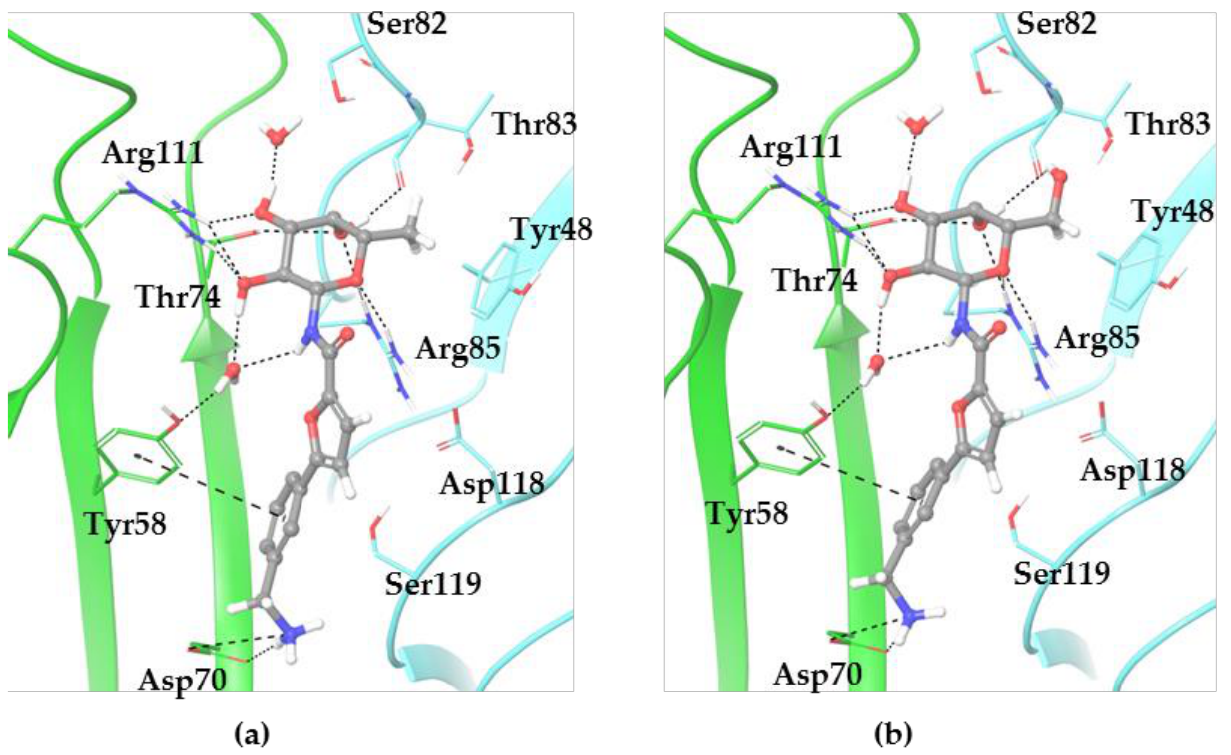
Figure 2. Expected binding mode of ( a ) 3 and ( b ) 4 in BC2L-C-Nt. The poses were obtained by docking using Glide (vers. 7.8), according to the protocol described in ref